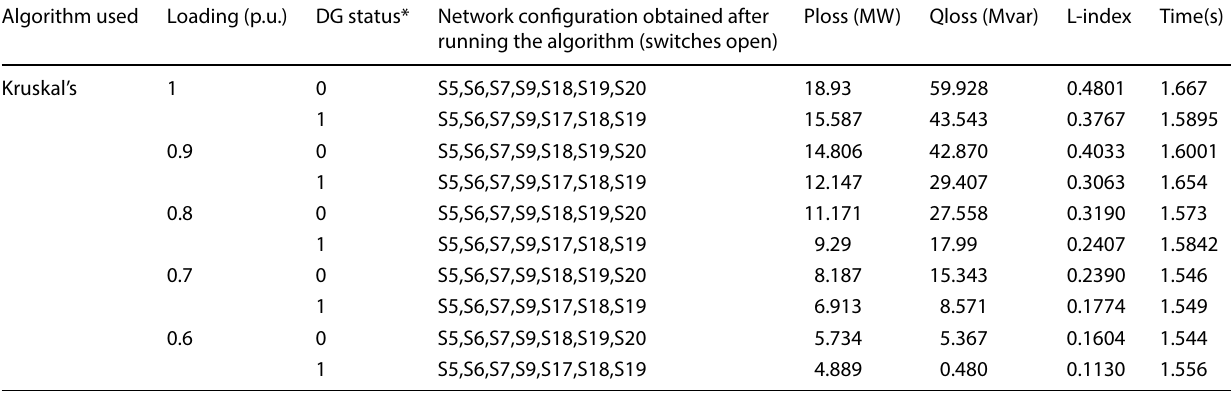
Table 10 Comparison of the radial networks obtained via manual switching and via application of Kruskal algorithm for a 14-node test sys- tem with and without DG integration Algorithm used Loading (p.u.)